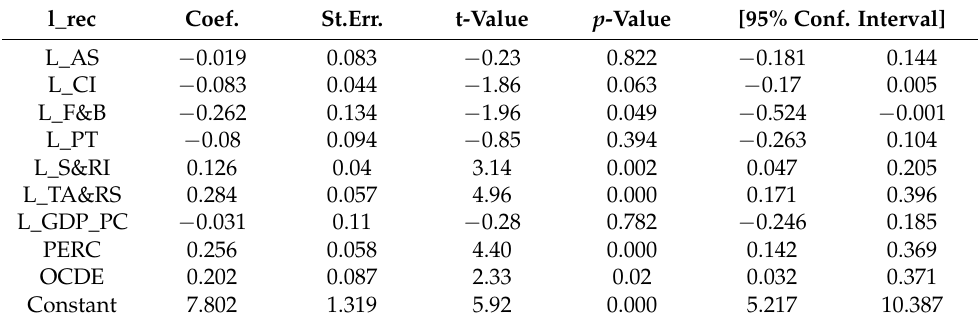
Table A9. Panel data estimations of the explanatory variables of tourism receipts (in logarithm) for the countries in the sample. Fixed effects heteroskedastic panel with corrected standard errors